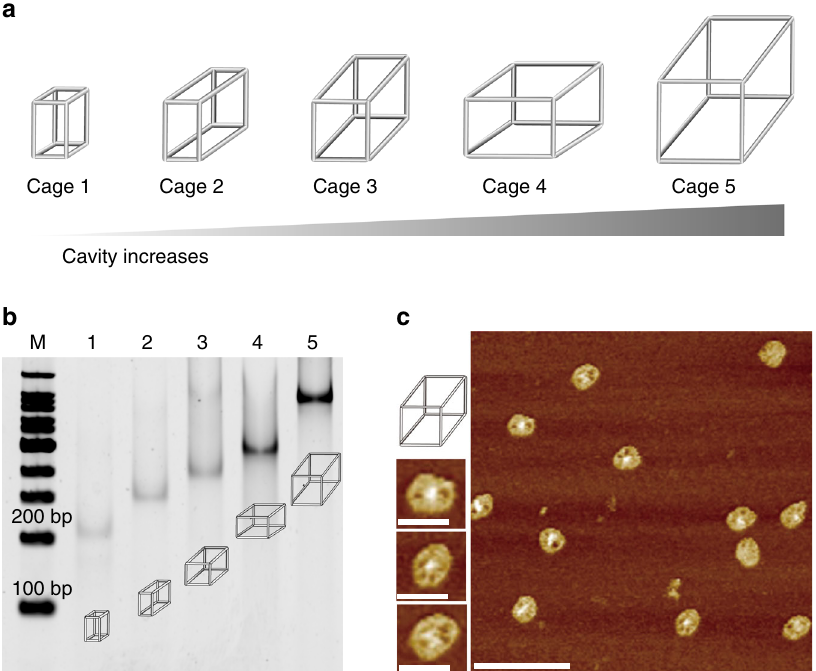
Fig. 3 Design and characterization of DNA nanocages with different cavity sizes. a Schematic illustration of DNA nanocages construction. The cavity of DNA nanocages gradually increases from cage 1 to cage 5. b N-PAGE characterization of DNA nanocages from cage 1 (lane 1) to cage 5 (lane 5). c Atomic force microscopy characterization of DNA nanocages (Cage 5). The scale bars are 100 and 30 nm in large and small imaging, respectively. Source data are provided as a Source Data fi